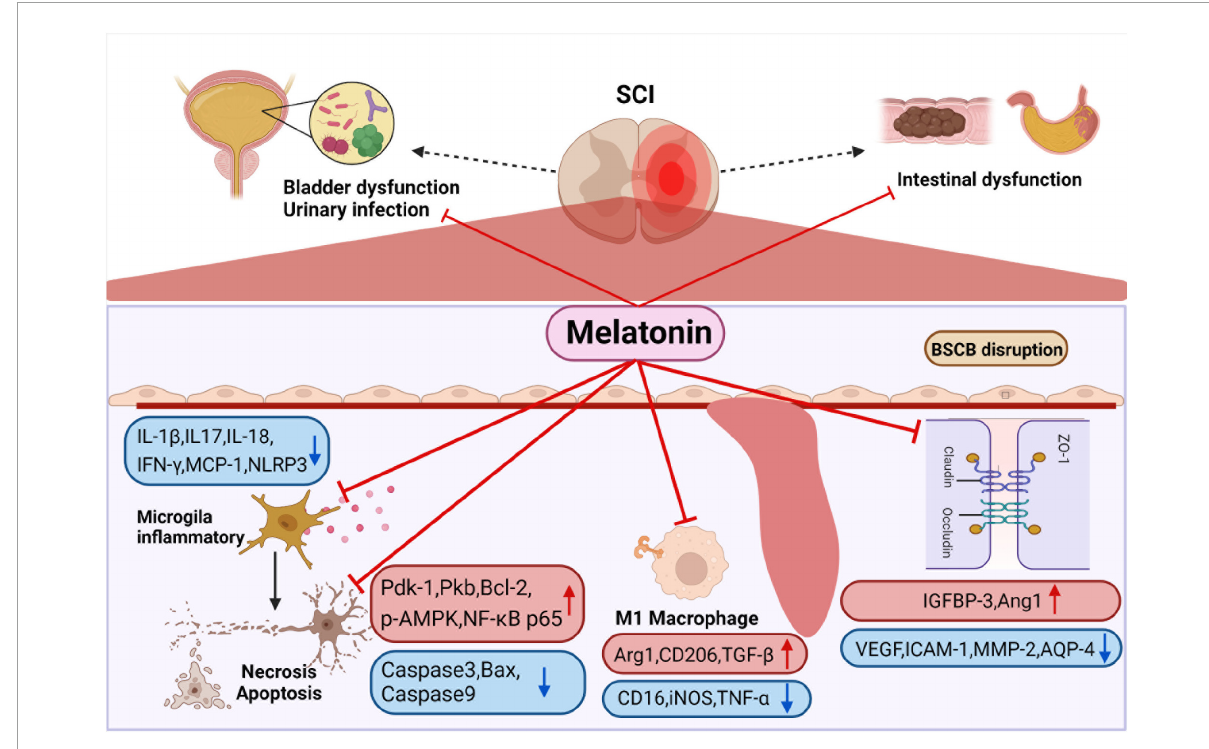
FIGURE3 Smooth muscle dysfunction leads to constipation and fecal incontinence after SCI. Melatonin can enhance intestinal motility to promote emptying. It can also improve colonizing dominant bacteria abundance to reduce the probability of urinary infection. Melatonin inhibits the activation of M1 macrophage after SCI, the release of a variety of inflammatory factors are suppressed, and at the same time regulates apoptosis-related proteins to inhibit the apoptosis of nerve cells. In addition, melatonin regulates channel-related proteins to maintain the stability of blood-spinal cord barrier and reduce edema. Created with